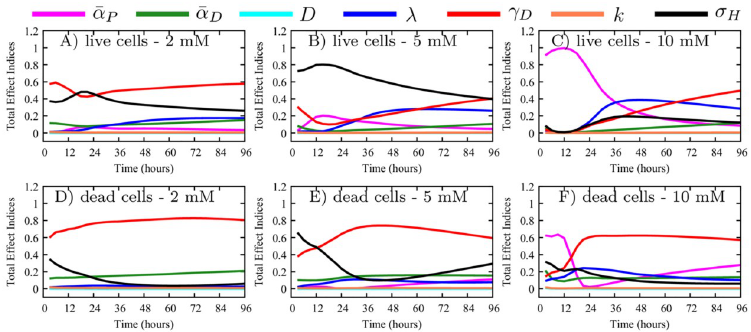
Fig 6. Medium confluence sensitivity analysis. Sensitivity analysis of proliferation rate ( � a diffusion ( D ), glucose uptake ( λ ), death rate increase due to lack of glucose ( γ glucose threshold ( σ H ) for live (top row) and dead (bottom row) cell phenotypes seeded with medium confluence. Panels A-F show the total effect index over time with Panels A, B, and C depicting live tumor cells, while Panels D, E, and F depict the dead tumor cells. The importance of the parameters is studied for three initial glucose concentrations: 2 mM (Panels A and D), 5 mM (Panels B and E), and 10 mM (Panels C and F). The glucose diffusion and the smooth transition constant have limited influence on the quantities of interest during the complete simulation (i.e., large changes in these parameters would yield small changes in tumor composition). Apart from these two parameters, the total effect index for every parameter is greater than 0.2 during the 96 hours